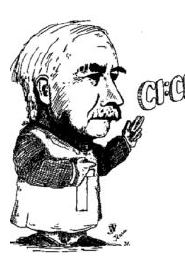
Figure 2. A cartoon of Lewis showing his electron dot model for the electron-pair holding Cl 2 . Adapted by permission of the creator of the cartoon, W.B. Jensen.